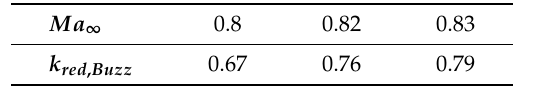
Table 1. Corresponding reduced frequencies k red , Buzz of selected buzz conditions.